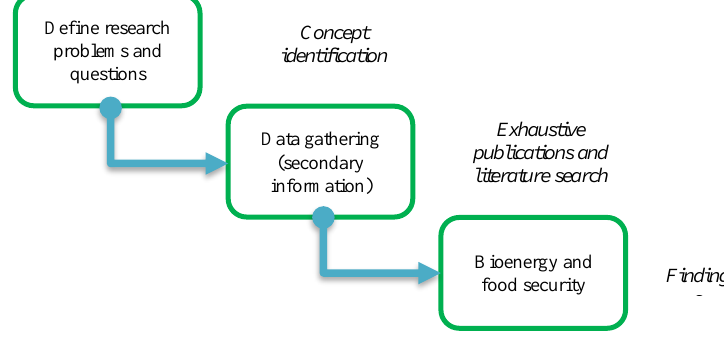
Fig. 1. Exploratory research approach (adapted by